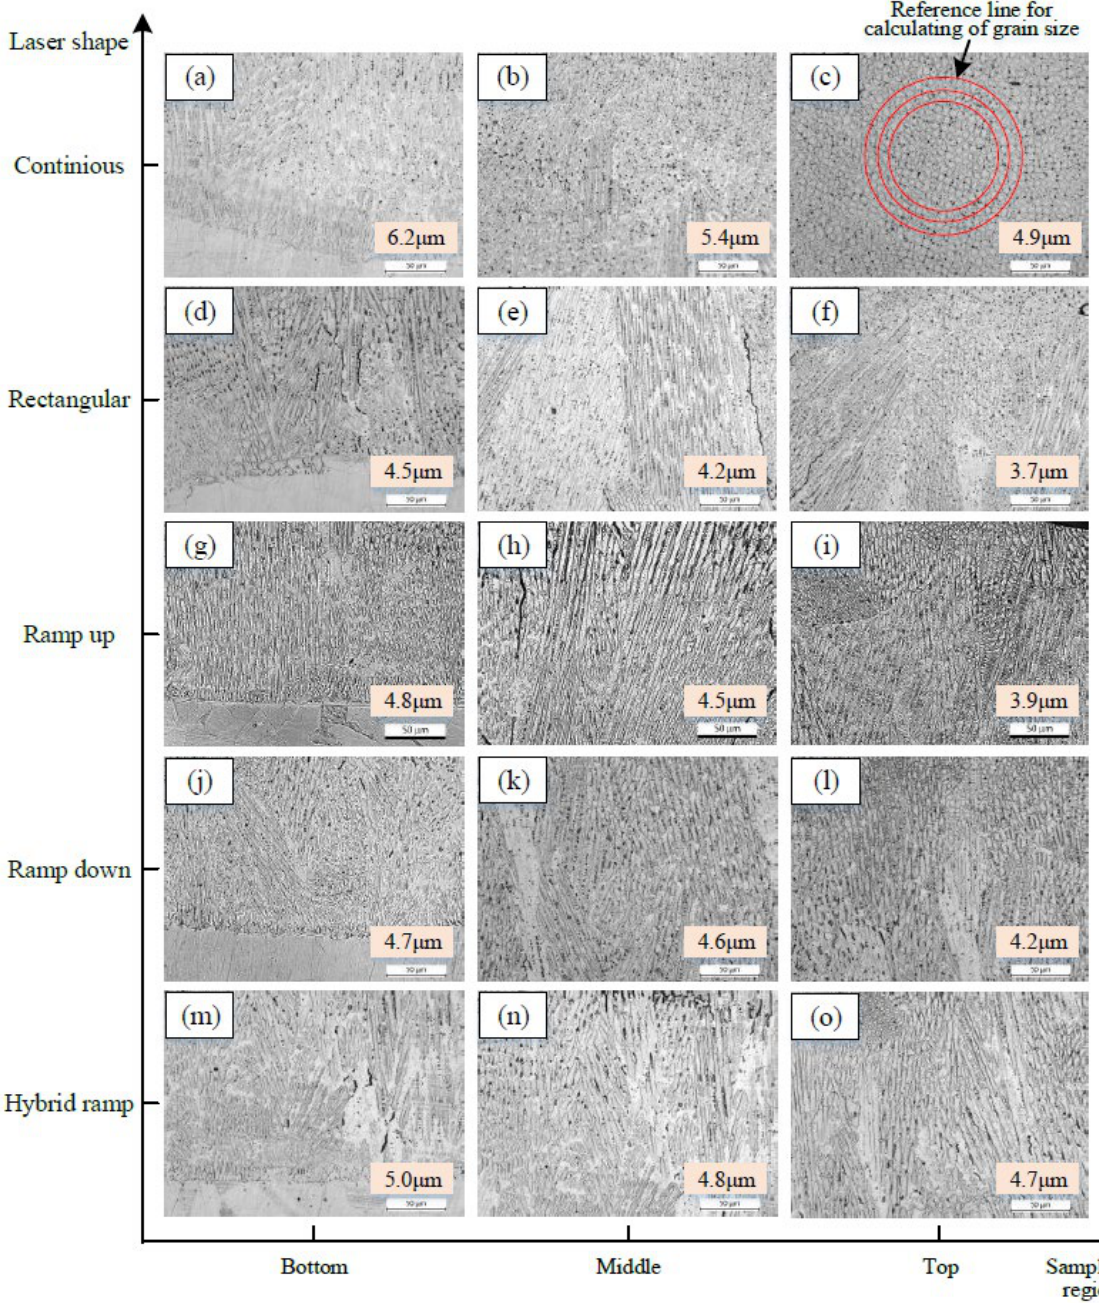
Figure 6. The microstructures of clad at different regions of deposition created by different laser shapes. Bottom region of deposition by ( a ) continuous, ( d ) rectangular, ( g ) ramp up, ( j ) ramp down, ( m ) hybrid ramp laser shape; Middle region of deposition by ( b ) continuous, ( e ) rectangular, ( h ) ramp up, ( k ) ramp down, ( n ) hybrid ramp laser shape; Top region of deposition by ( c ) continuous, ( f ) rectangular, ( i ) ramp up, ( l ) ramp down, ( o ) hybrid ramp laser shape.